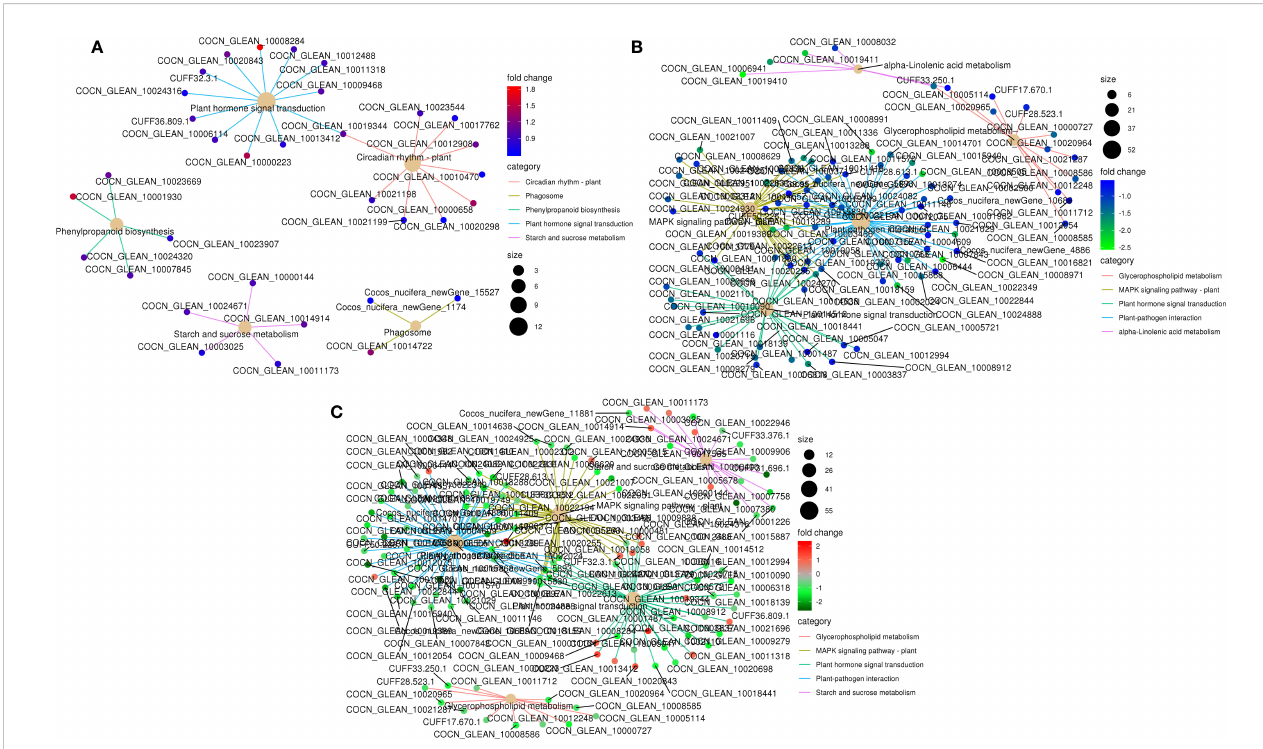
FIGURE 5 KEGG pathway enrichment network of DEGs in the top fi ve enriched pathways in K 0 vs. K ck . (A) up-regulated DEGs, (B) down-regulated DEGs, and (C) all DEGs. Line colors represent different pathways, and gene node colors represent multiple